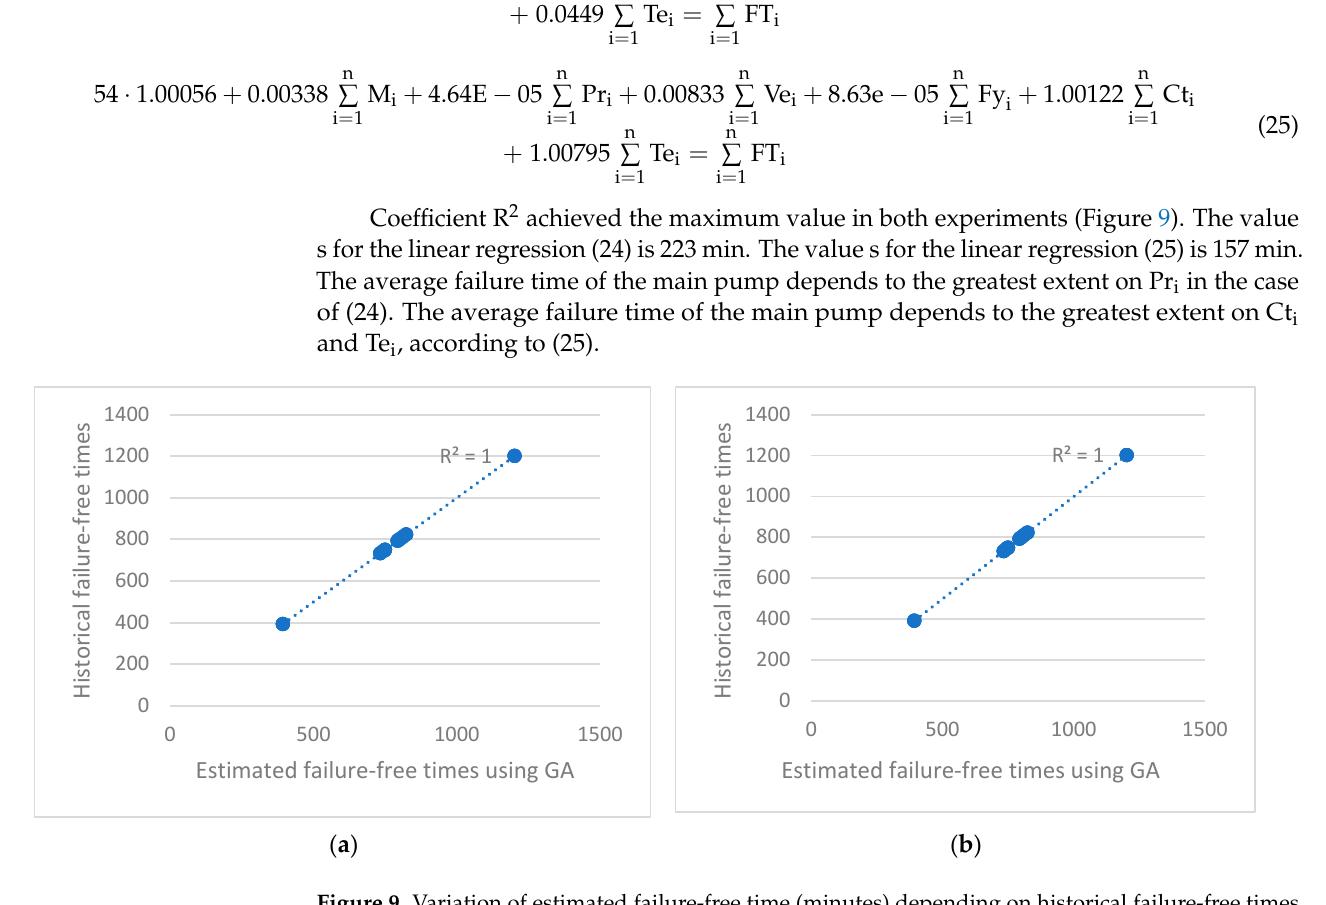
Figure 9. Variation of estimated failure-free time (minutes) depending on historical failure-free times achieved using ( a ) GA (24) and ( b ) GA (25).